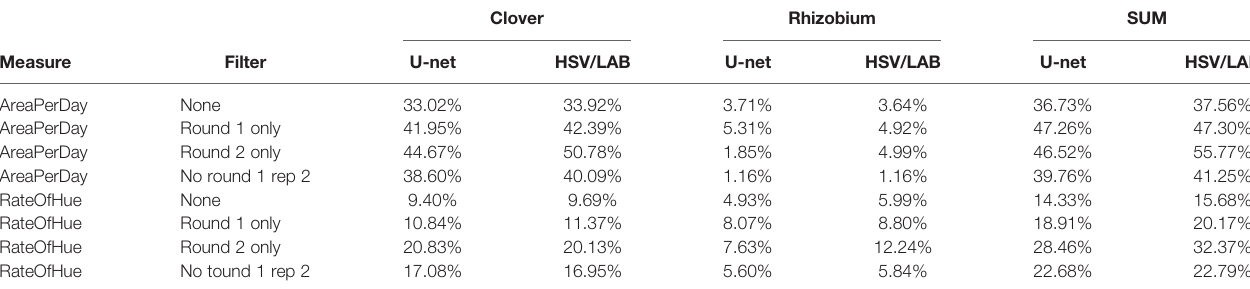
TABLE 4 | Broad sense heritability estimates for the measurements produced from the image data for both U-net and thresholding (HSV/LAB).